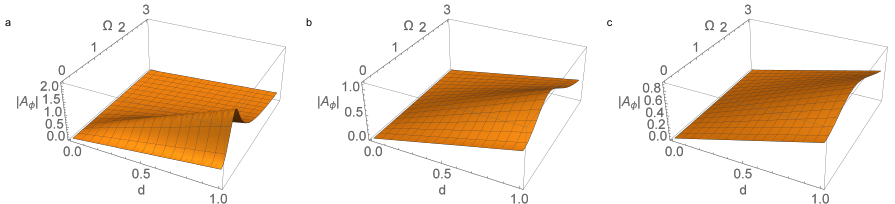
Figure 4. The amplitude of the forced oscillations of the pendulum | A ϕ ( d , Ω ) | according to (33) for values of the parameter γ , characterizing friction: ( a ) γ = 0.2; ( b ) γ = 1.1; and ( c ) γ = 1.9. The calculation was performed for σ = 0.5, α = 1.5, and ω = 1.2.